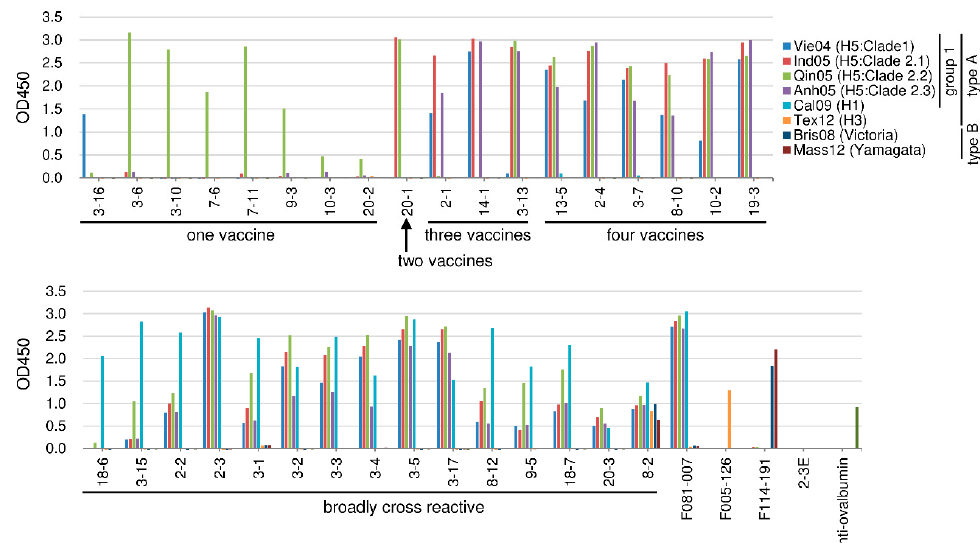
Figure 4. Binding activity of HI-negative clones. Binding activities of thirty-three clones to four H5N1 vaccine strains, H1N1, H3N2, and two kinds of type-B viruses, were examined by ELISA. F081-007 (an anti-H1 and -H5 HA antibody), F005-126 (an anti-H3 HA antibody), and F114-191 (an anti-influenza type-B antibody) were used as positive controls, while 2-3E (anti-rotavirus antibody) was used as a negative control. The binding activity is shown as the optical density at 450 nm (OD450).